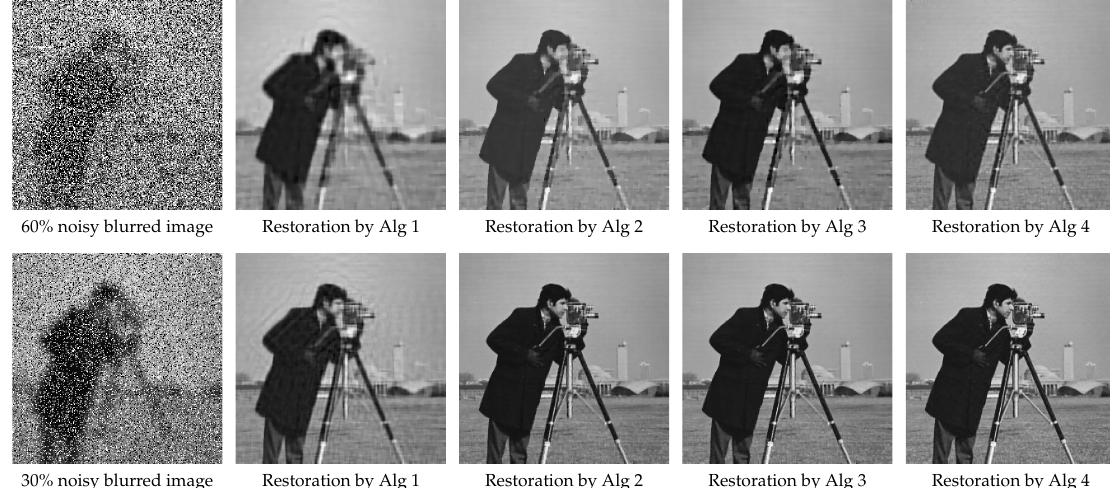
Figure 2. Image restoration for blurred Cameraman image with 60% or 30% salt-and-pepper